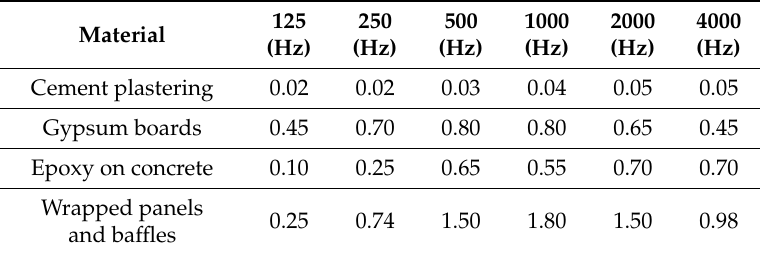
Table 2. Sound absorption coefficients ( α ) as a function of frequency for materials used in the simulation [53].